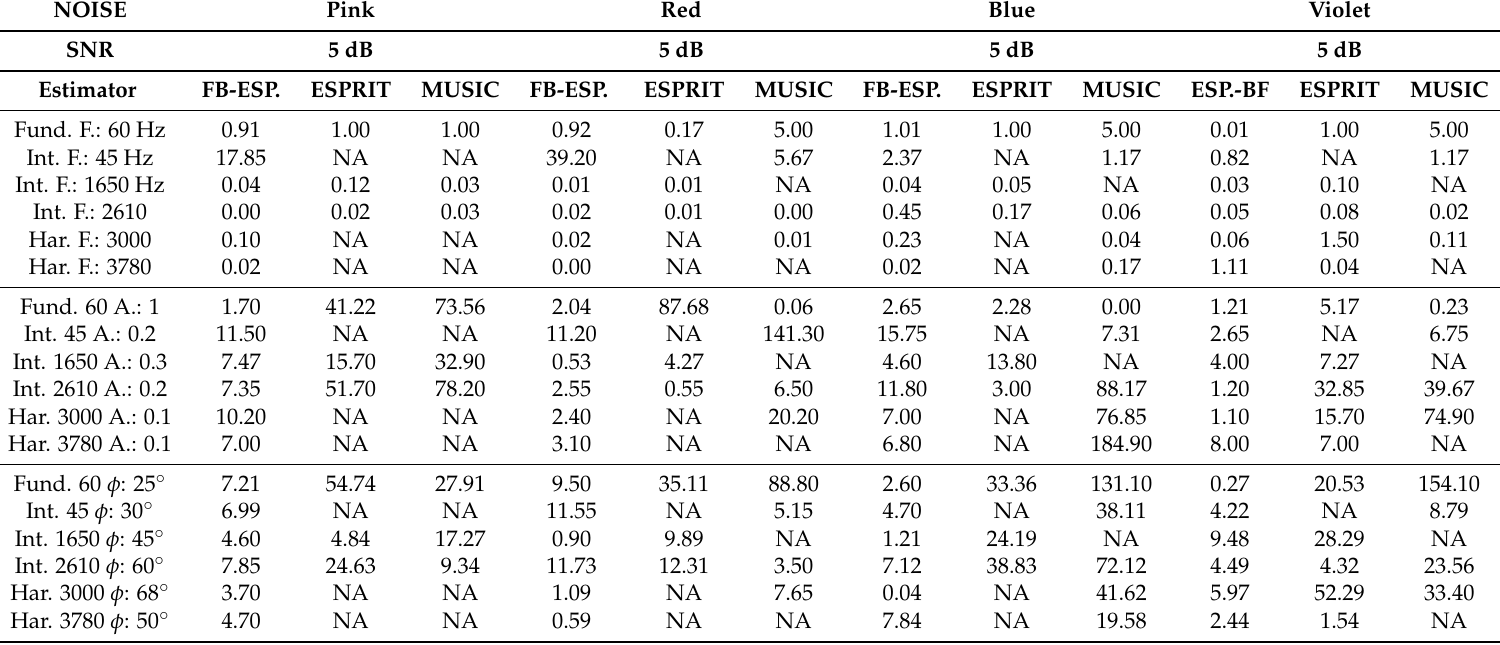
Table 9. Percent error (%) in the estimation of the parameters of signal s 2 ( t ) contaminated by pink, red, blue, and violet noises with an SNR of 5 dB in 1000 runs of FB-ESPRIT, ESPRIT, and MUSIC. NOISE Pink Red Blue